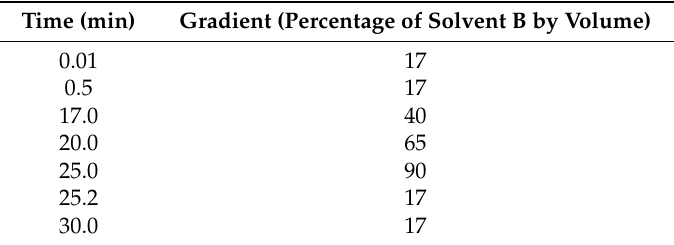
Table 3. UHPLC gradient